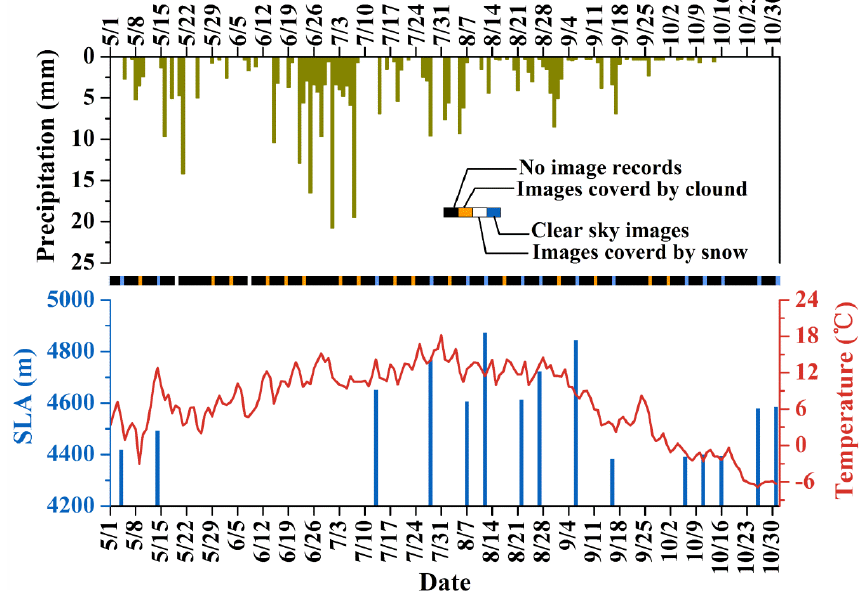
Figure 5. The SLAs extracted from Sentinel-2 images in warm season [26].